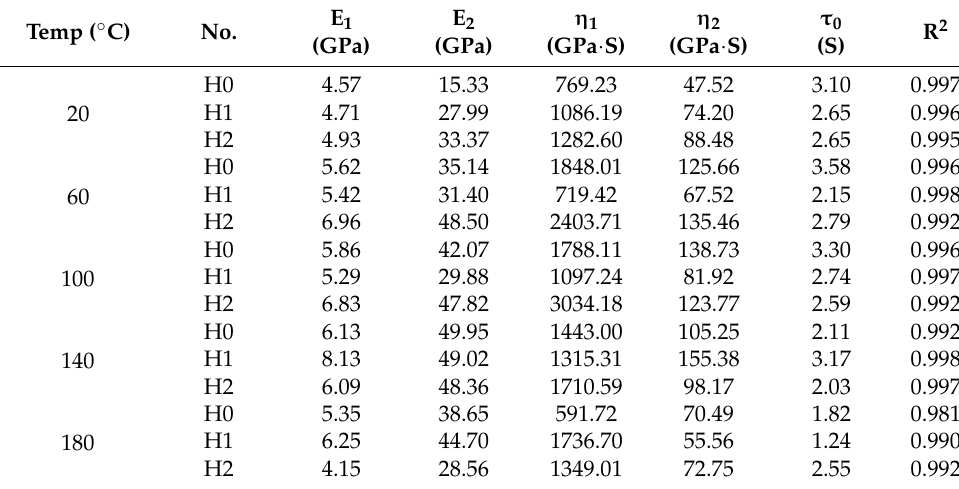
Table 1. Parameters of Burgers